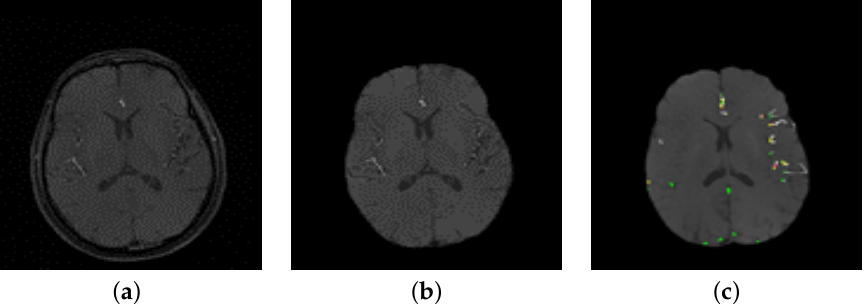
Figure 3. ( a ) A sample of a 2D raw image, ( b ) After preprocessing, ( c ) Initial segmentation using LCDG.